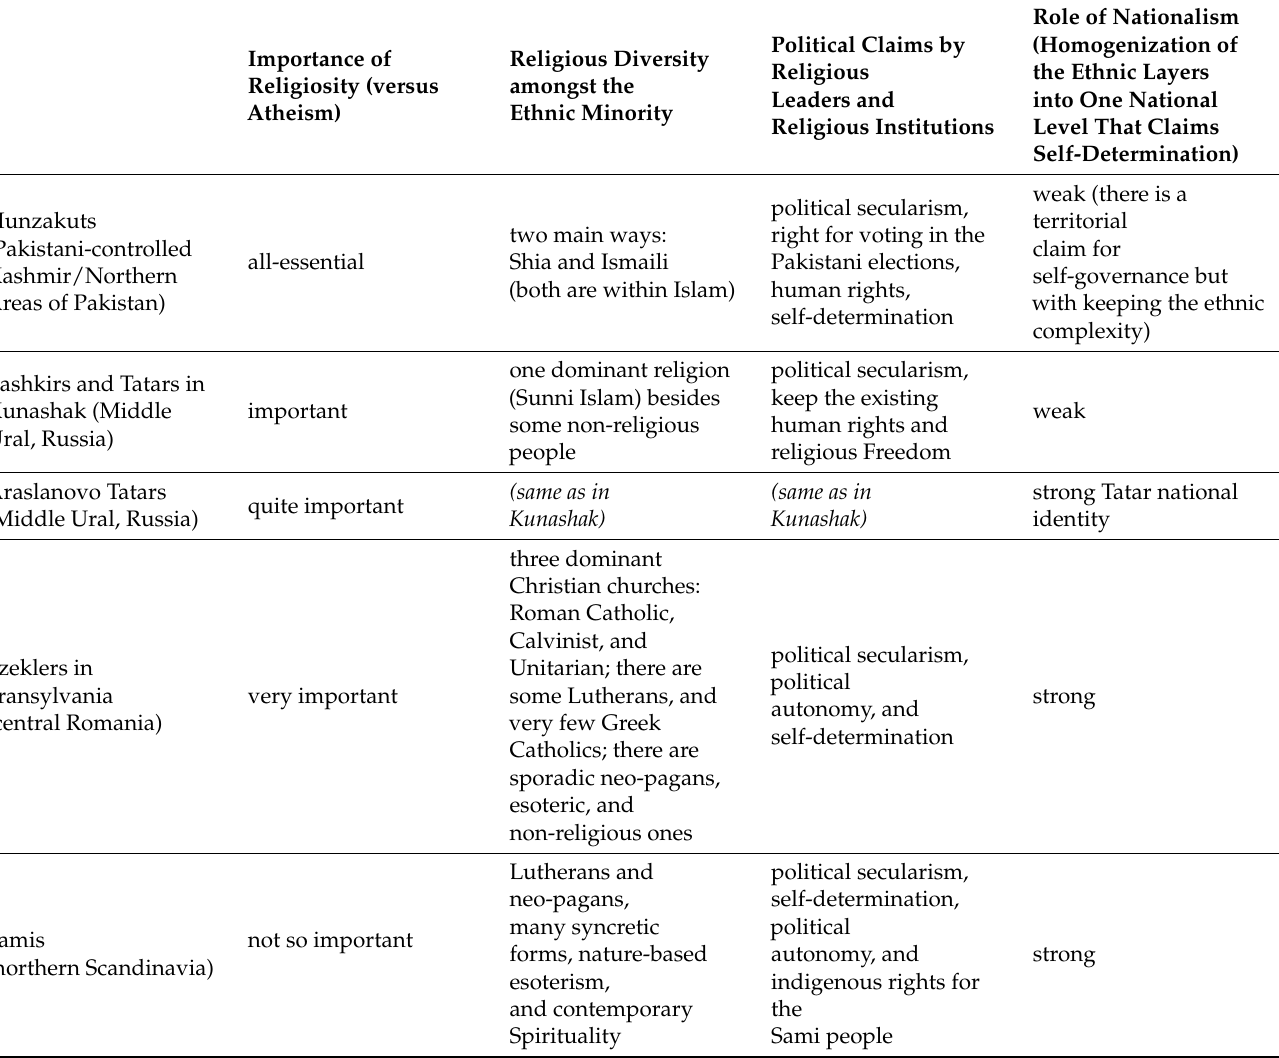
Table 2. Comparative matrix of the four case studies (importance of religiosity, diversity of religions, political claims of religious institutions, role of